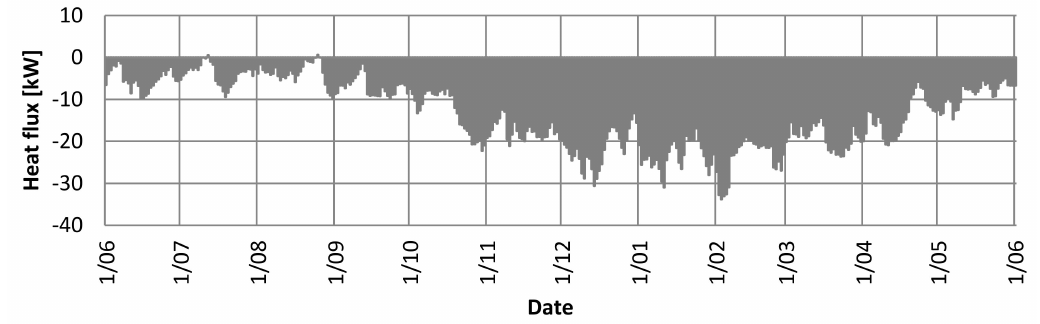
Figure 9. Building–soil heat exchange by